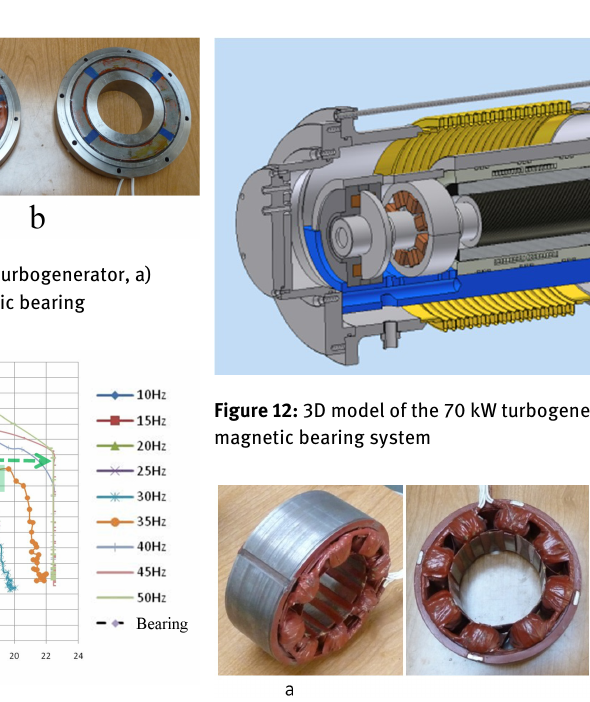
Figure 13: Oil-free bearings used in the 70 kW turbogenerator, a) magnetic journal bearing, b) thrust active magnetic